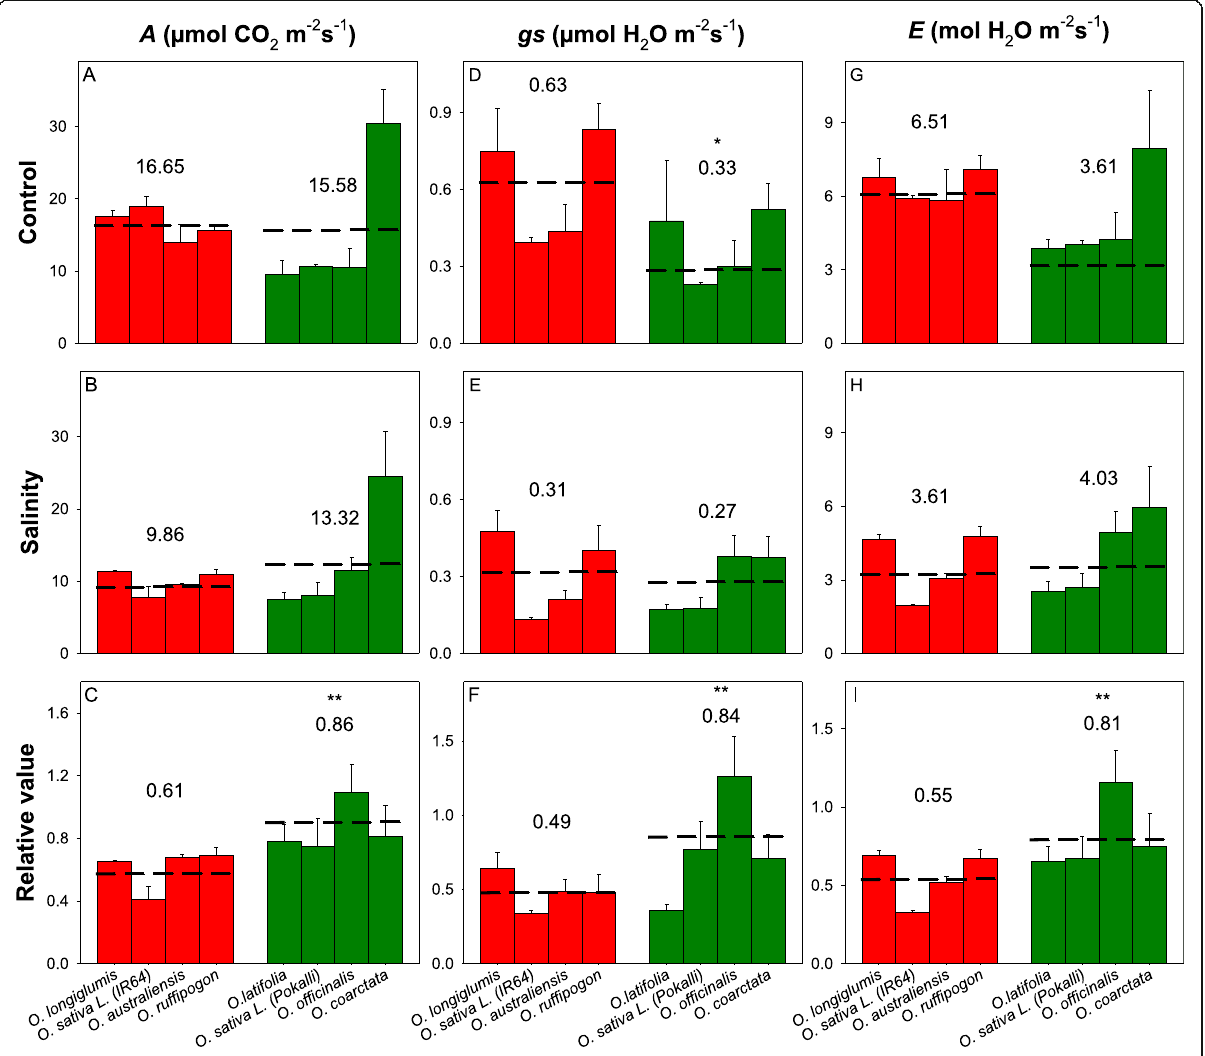
Fig. 1 Effects of 100 mM NaCl treatment on leaf gas exchange parameters of wild and the cultivated rice after six weeks of salinity stress . ( A-C ) net CO 2 assimilation rate, A ; ( D-F ) stomata conductance, g s ; and ( G-I ) transpiration rate, E. For each species, left bar (red) represents the sensitive species group and right bar (green) represents the tolerant species group. * and ** indicates significant difference found between sensitive and tolerant groups at P < 0.05 and P < 0.01 respectively, using independent sample t-test. The number and dashed line indicate the mean value of each group. The data are means and the error bars indicate the standard